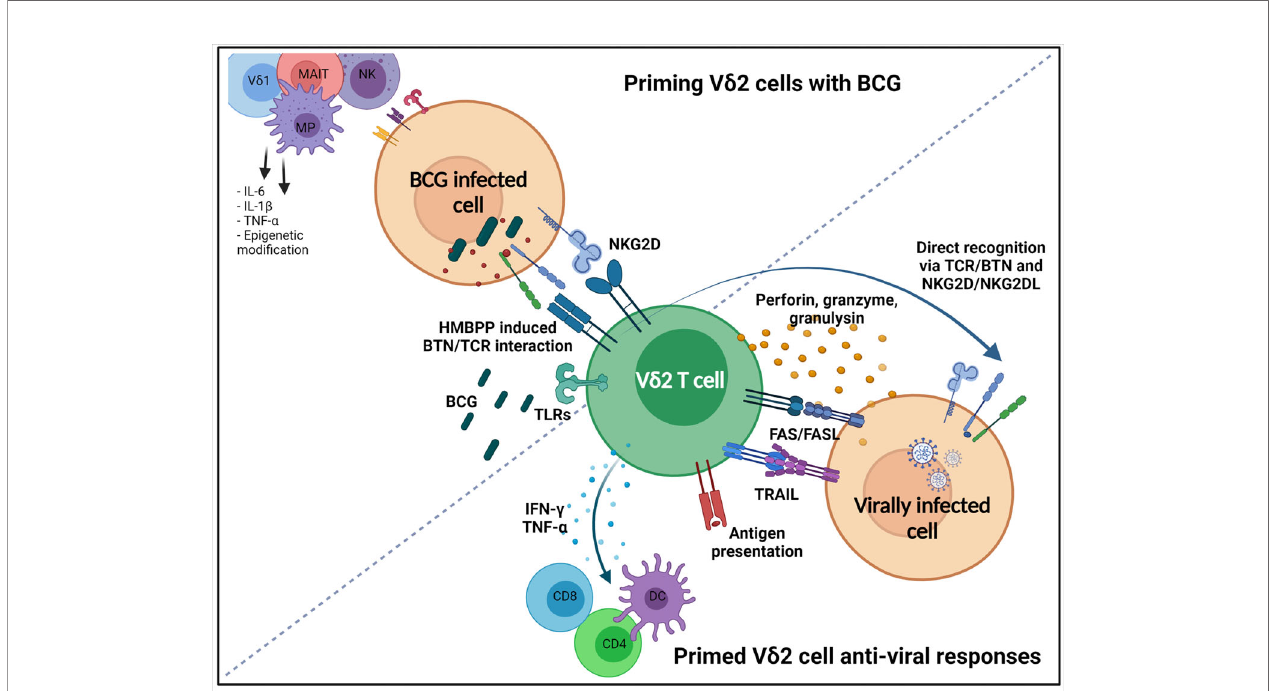
FIGURE 1 | Priming V d 2 cells with BCG, and subsequent non-speci fi c anti-viral responses. V d 2 T cells are activated after BCG vaccination through a number of mechanisms. HMBPP produced by BCG infected host cell causes conformational changes on intercellular domains of butyrophilin (BTN) molecules, such as BTN3A1 and BTN2A1, which allows the extracellular domain to interact with the V d 2 TCR. Mycobacteria have been shown to induce the expression of NKG2D ligands on cells which can activate V d 2 cells through NKG2D. V d 2 cells have many TLRs that can recognize BCG PAMPs. Non-speci fi c responses induced that have anti-viral activity include directly killing infected cells through the secretion of cytotoxic granules containing perforin, granzymes and granulysin, or initiation of death-inducing pathways, FASL and TRAIL. They can also indirectly contribute to killing through the production of pro-in fl ammatory cytokines TNF- a and IFN- g inducing the maturation and migration of DCs, leading to induction of the adaptive immune system. V d 2 cells may also recognize virally infected cells directly via NKG2D and V d 2 TCR. Infected cells can upregulate NKG2D ligands (e.g. MICA, MICB), and can have altered metabolisms, which induces conformation changes to BTN molecules. Created with